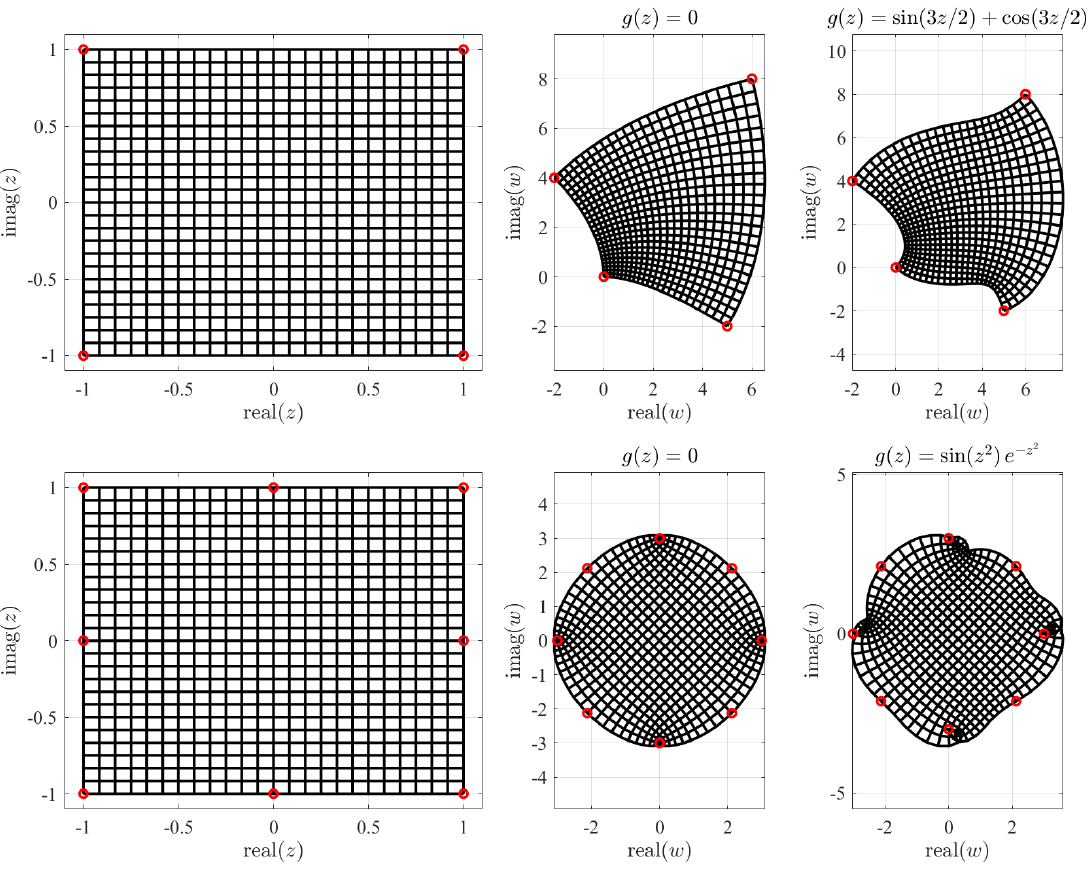
Figure 2. Rubber effect on the W domain by the TFC free